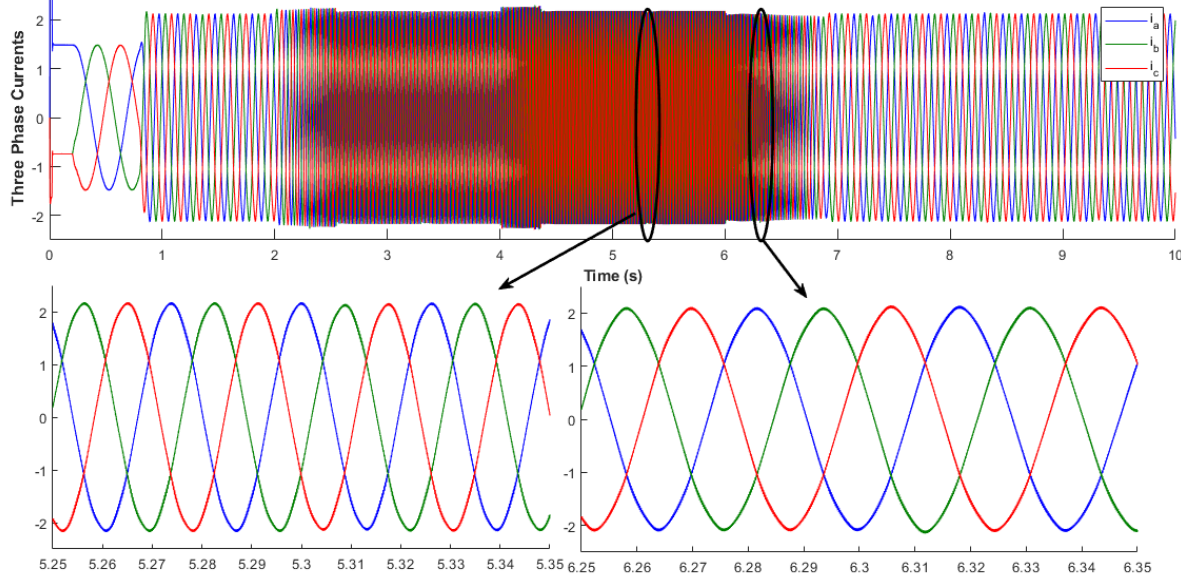
Figure 20. Stator currents for the neural voter.